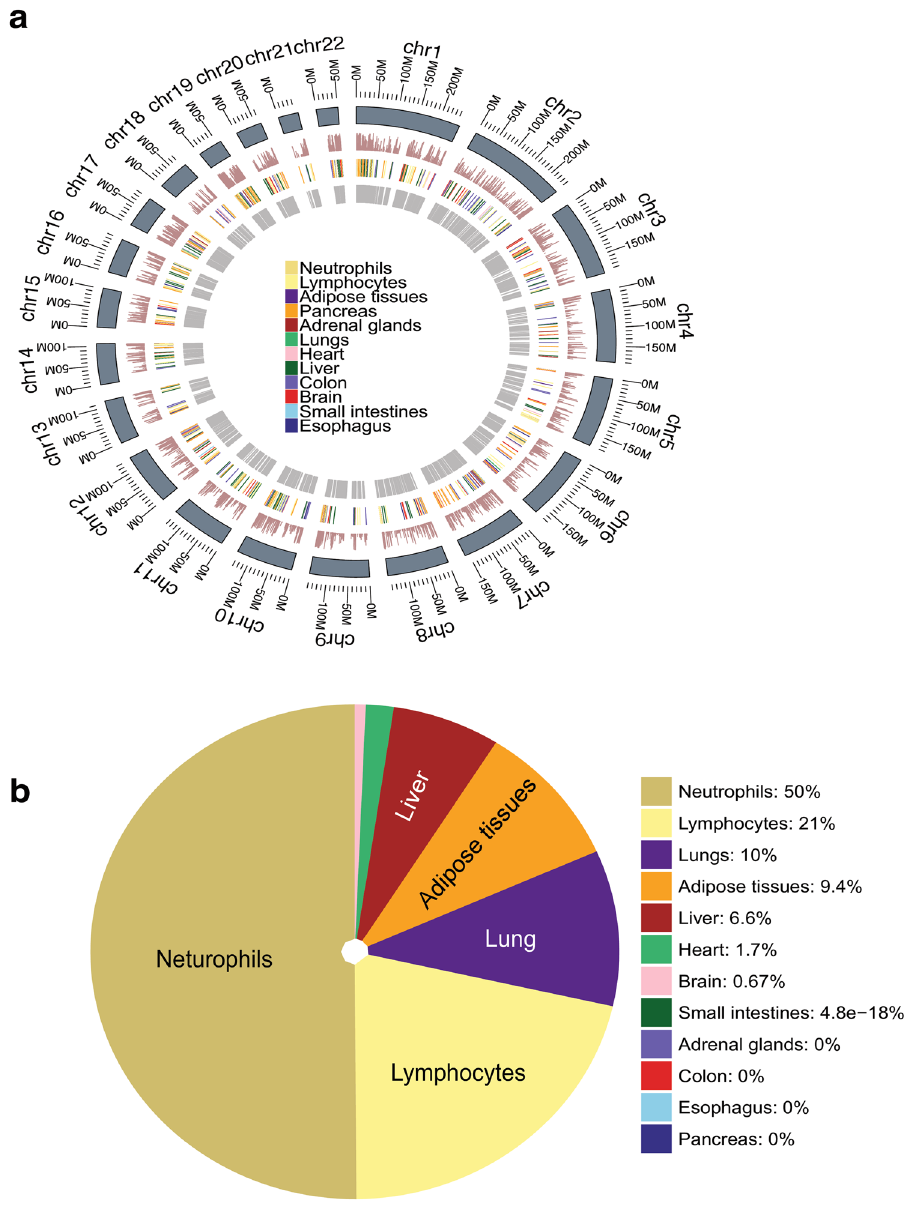
Figure 5. Bisulfite sequencing of plasma cfDNA. Three separate TGIRT-seq libraries were each constructed from ~5 ng of bisulfite-treated plasma DNA from a healthy male individual, and sequenced to obtain TGIRT- seq datasets BPD1-3 (see Supplementary Table S4). The datasets were combined and analyzed to identify DNA methylation sites, as described in Methods. ( a ) Annotation of DNA methylation sites in the human genome and determination of DNA methylation densities by TGIRT-seq of bisulfite-treated plasma cfDNA. Tracks from the inner to the outer circle represent: (1) annotations of Type II biomarkers that are highly variable in methylation density across tissues; (2) annotations of Type I biomarkers that are highly tissue specific (color- coded); (3) bar graphs of methylation densities within the annotated regions based on TGIRT-seq of bisulfite- treated plasma cfDNA; (4) genome coordinates. ( b ) Tissues-of-origin of plasma cfDNA from a healthy male individual determined by TGIRT-seq of bisulfite-treated DNA. The pie chart shows the percent contributions of different tissues in combined datasets PB1-3 determined by quadratic programming 7 . Neutrophils are derived from myeloid precursors, and lymphocytes are a combination of T-cells and B-cells. Comparison of tissues-of- origin of plasma cfDNA determined as in panel ( b ) from the three independent datasets BPD1-3 are shown in Supplementary Fig. 11. Pearson’s correlation coefficients were ≥ 0.96 for each pairwise combination of the three individual